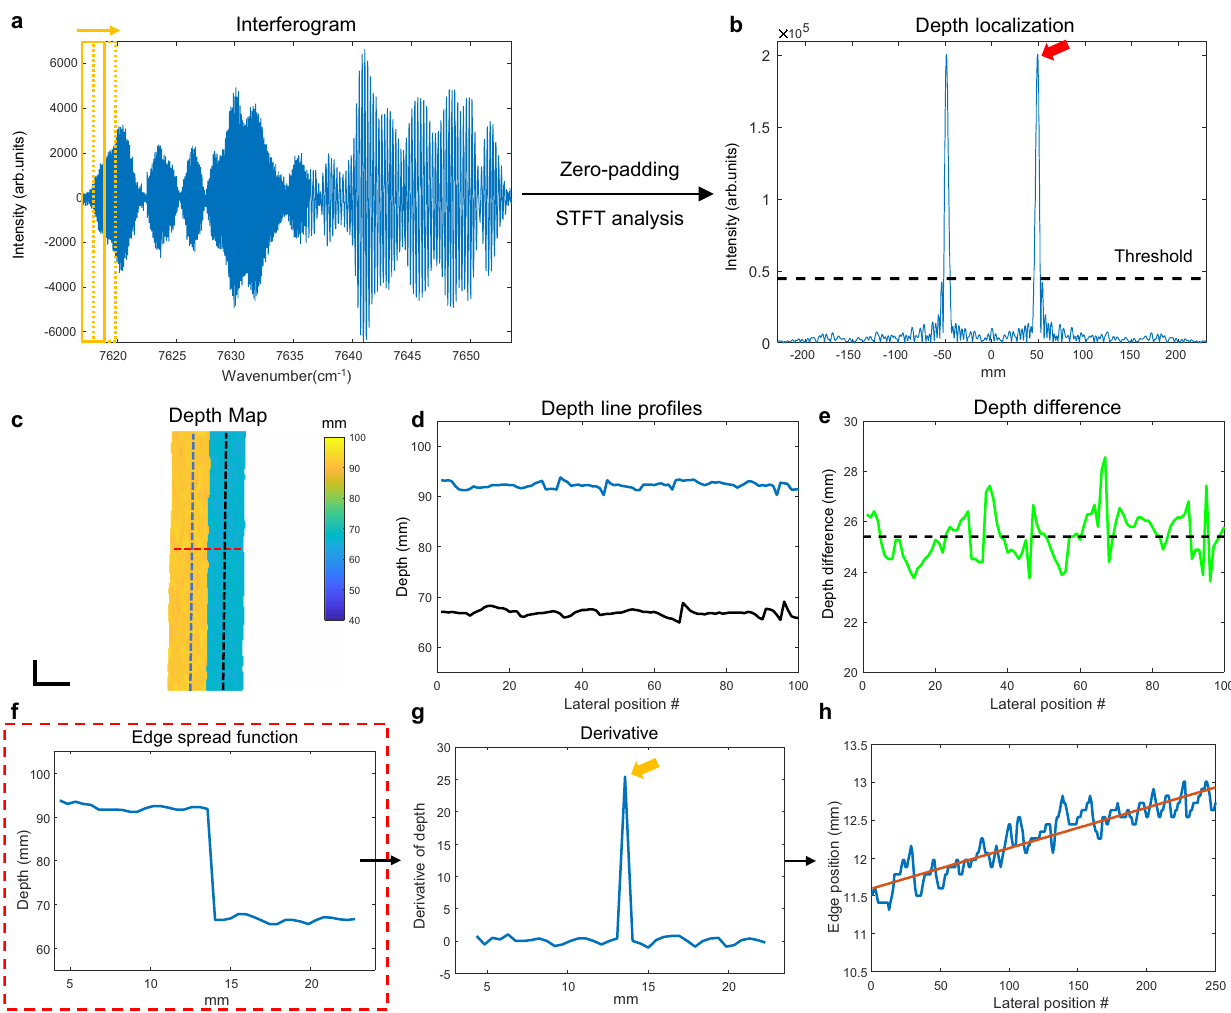
Fig. 2 Signal processing and system performance characterization of the time-frequency multiplexed FMCW LiDAR system. a Short-time Fourier Transform (STFT) analysis to retrieve the depths of re fl ectors along the grating axis and b depth localization from the signal after FT and. c Depth map of two staggered metal base plates separated by 25.4 mm, scale bar: 1 cm. d , e The “ scanning spot ” axial localization precision and accuracy characterization: d depth pro fi les along two lines of the front (black line in c ) and back metal plates (blue line in c ) and e their depth differences. f , h The lateral localization precision characterization: f the edge spread function of the depth pro fi le along the red line in c and g the edge localization from its calculated derivative function, and h the residual localization error measured at 250 lateral